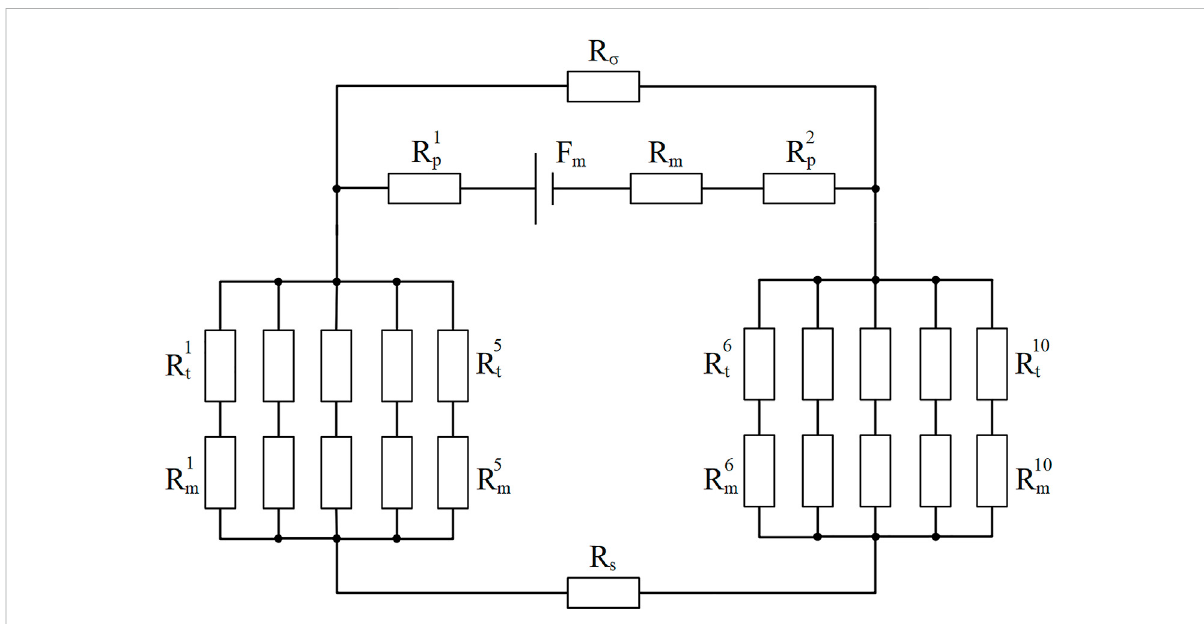
FIGURE 4 Equivalent magnetic circuit of the sealing structure. (F m is the magnetomotive force of the magnet, and R m , R p , R t , R m , R s , R σ are the magnetic resistance of the magnet, pole piece, pole tooth, magnetic sealing media, shaft and magnetic fl ux leakage path, respectively.)